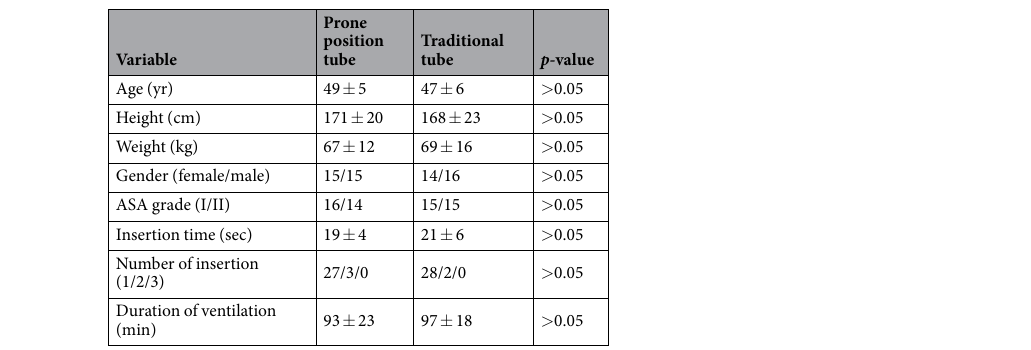
Table 1. The general information of the patients. Values are mean ± SD or number of patients. n = 30 in PPT group, n = 30 in TT